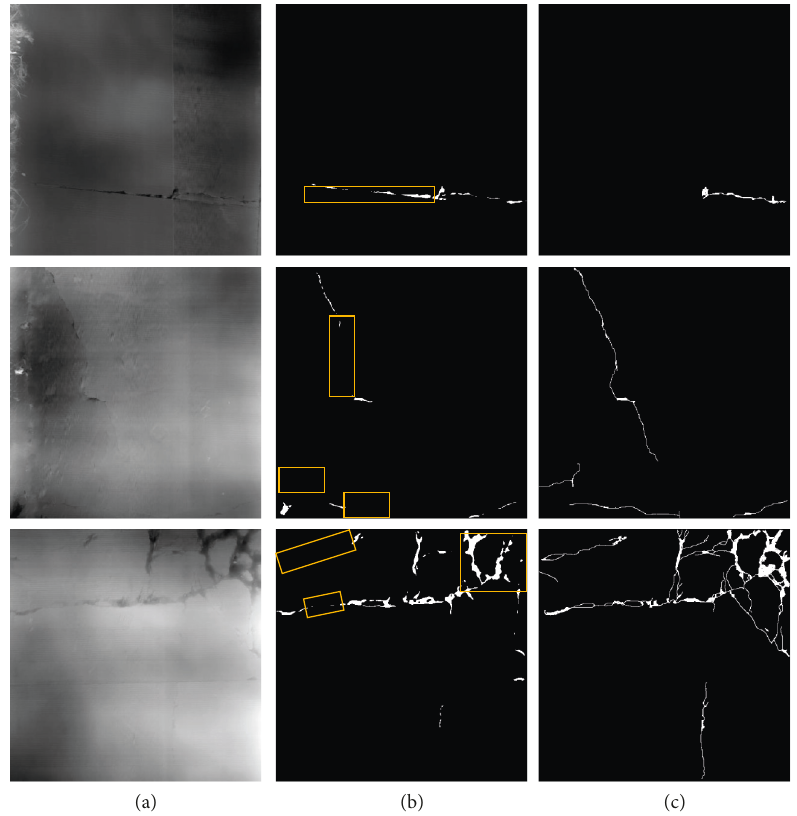
Figure 8: Typical errors resulting from PDSNet. (a) pavement images, (b) GA-Unet, and (c) ground